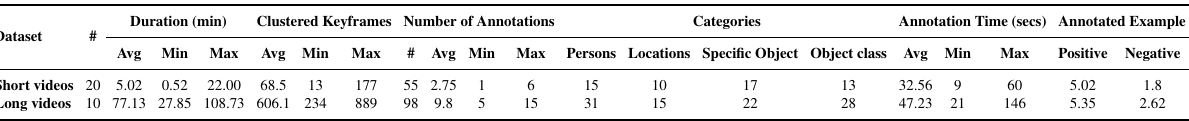
Table 1. Statistics about the used video